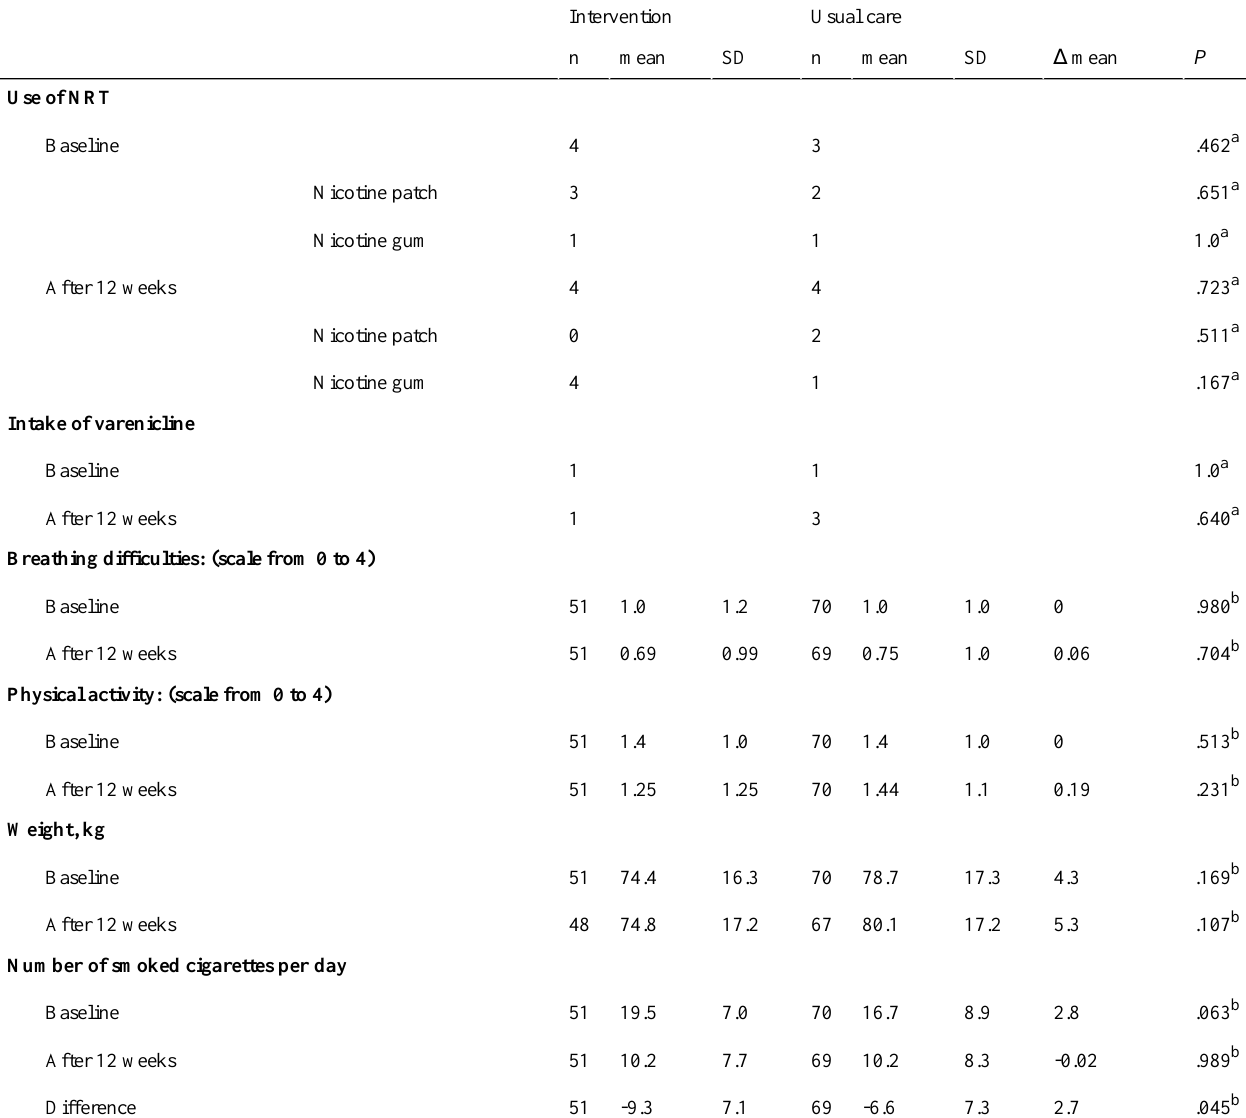
Table 3. Results of NRT, breathing difficulties, physical activity, weight, and number of smoked cigarettes per day (complete-case analysis).